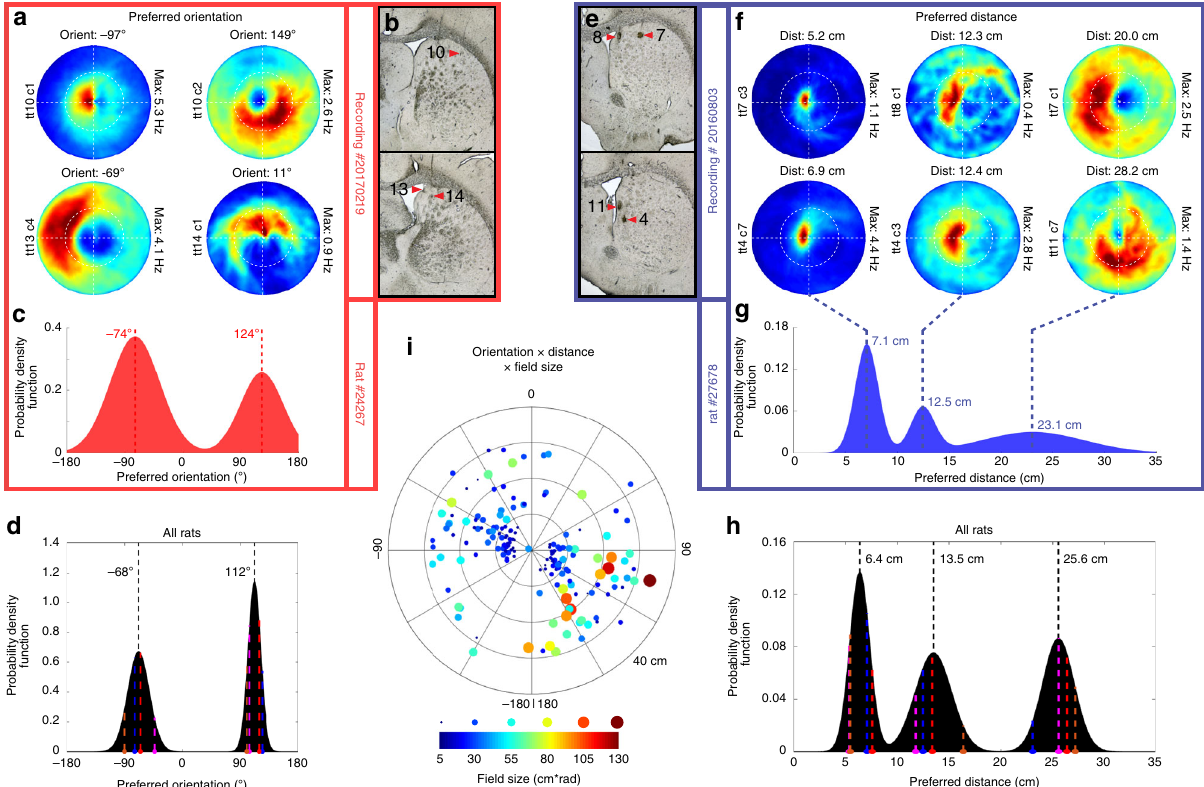
Fig. 2 Preferred orientation and distance of egocentric boundary cells (EBCs). a Egocentric boundary ratemaps for four simultaneously recorded EBCs with different preferred orientations, speci fi ed above each plot, tetrode (tt) number and cell (c) number displayed to the left of each plot and the maximum fi ring rate displayed to the right of each plot. b Final tetrode locations for cells shown in a . Numbers indicate the tetrode number. c Probability distribution function of preferred orientation for all EBCs from a single rat. d Probability distribution function of EBC preferred orientation peaks from all rats. Colored dashed lines indicate peak locations from each animal. e Final tetrode locations for cells shown in f . f Egocentric boundary ratemaps for six simultaneously recorded EBCs with different preferred distances speci fi ed above each plot, tetrode (tt) number and cell (c) number displayed to the left of each plot and the maximum fi ring rate displayed to the right of each plot. g Probability distribution function of preferred distance for all EBCs from a single rat. h Probability distribution function of EBC preferred distance peaks from all rats. Colored dashed lines indicate peak locations from each animal. i Polar scatter plot of preferred distance vs. preferred orientation for all EBCs with fi eld size represented with both color and dot